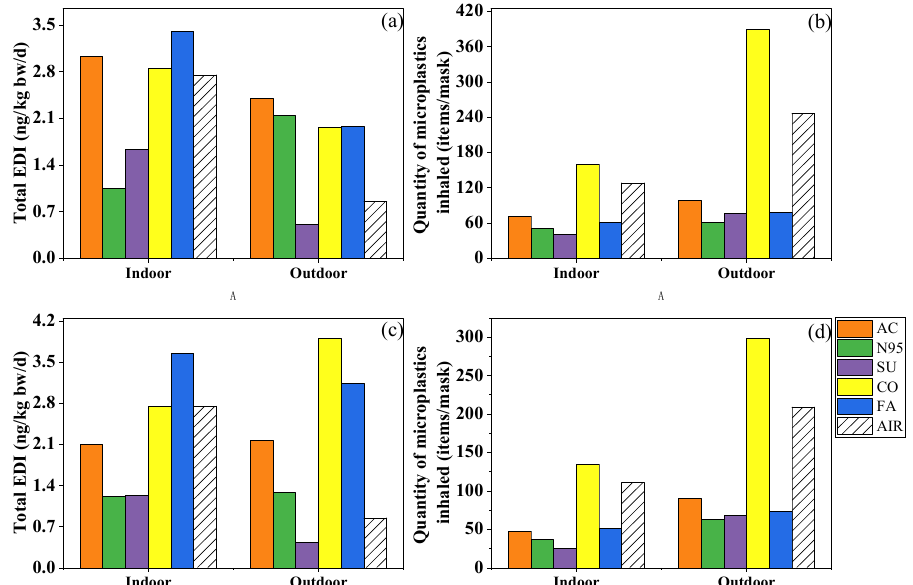
Figure 5. Total estimated daily intake of phthalates ( a , c ) and quantity of microplastics inhaled ( b , d ) by an adult while wearing activated-carbon mask (AC), N95 mask (N95), surgical mask (SU), cotton mask (CO), fashion mask (FA), and wearing no mask (AIR) in indoor and outdoor conditions. ( a ) and ( b ) simulated the condition in which the mask was changed after 4 h and kept for later 2 h, while ( c , d ) were based on the mass of phthalates and number of microplastics collected after 6 h.